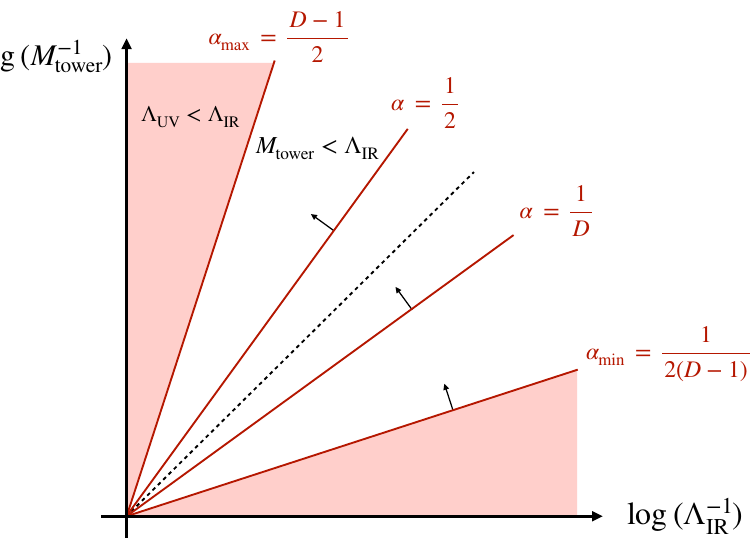
Figure 3 . The tower and the IR lengths are linearly related in log scale. The upper limit for the slope comes from Λ UV > Λ IR . The lower bound on the slope comes from the holographic constraint and depends on the number of dimensions D and the type of tower(s) p as in eq. (4.2). The absolute minimum value α min is obtained for large p (e.g. in the presence of a string tower) and α max for p = 1 . However, the CKN bound requires p ≤ D and α D ≥ 1 /D